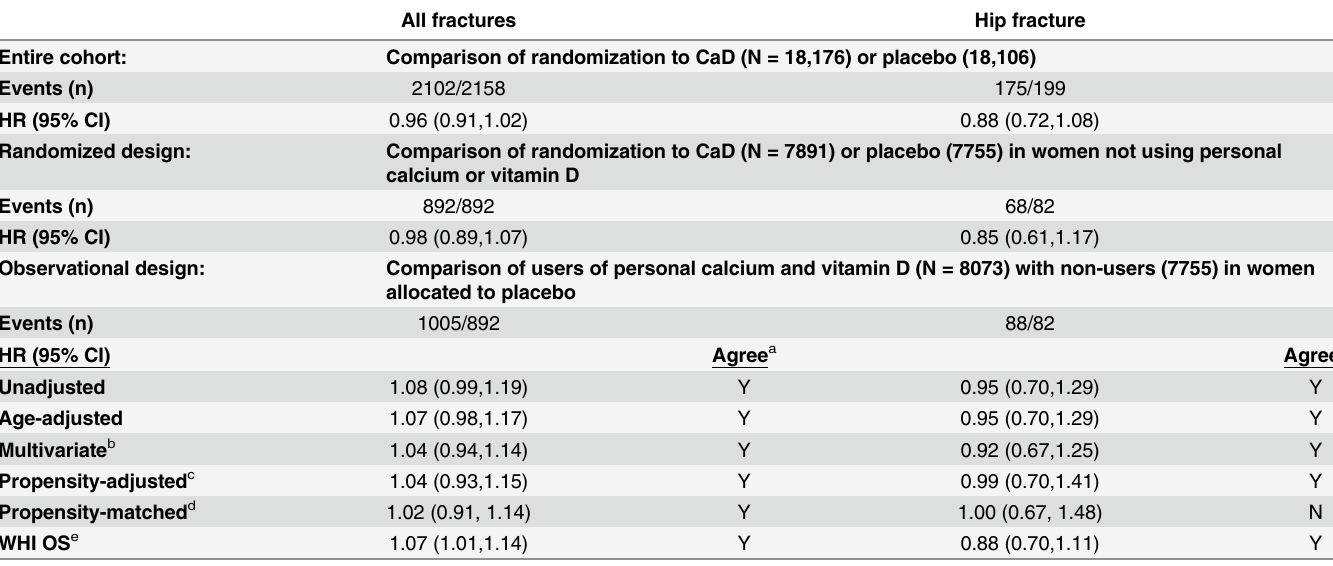
Table 3. Comparison of results from the randomized and observational designs for fracture. All fractures Hip